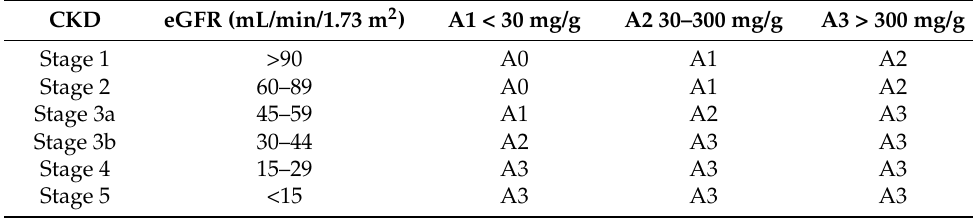
Figure 1. Diagnostic criteria for CKD. Table 1. The stages of chronic kidney disease 1 .